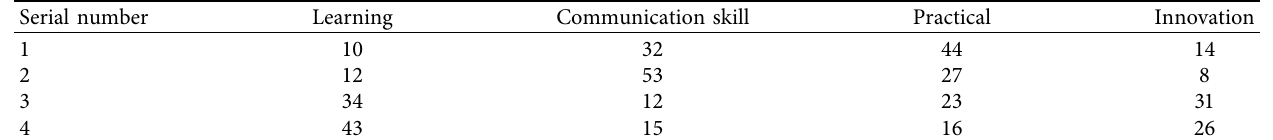
Table 4: Ability quality.